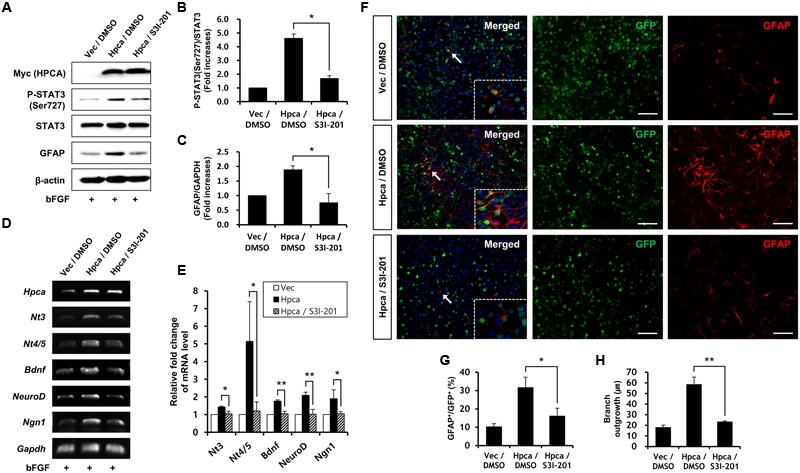
Inhibitory effect of STAT3 (Ser727) activation on astrocytic differentiation of HNPCs. (A) HNPCs were transfected with pMSCV-IRES-EGFP or pMSCV-Hpca-myc-IRES-EGFP for 48 h and then treated with 10 μM S3I-201 for 24 h. Cells were lysed and analyzed by western blotting with anti-Myc, anti-p-STAT3 (Ser727), anti-STAT3, anti-GFAP, and anti-β-actin. (B,C) Graphs show mean densities as fold increases from three independent experiments (means ± SD). Band intensities were quantified with Quantity Ones® software. ∗p < 0.01 compared with the Hpca/DMSO. (D,E) Cells were transfected with pMSCV-IRES-EGFP or pMSCV-Hpca-myc-IRES-EGFP for 48 h and then treated with 10 μM S3I-201 for 24 h. mRNA levels of neurotrophins and proneural bHLH transcription factors were measured by RT-PCR (D) and real-time PCR (E). Graph shows mean densities as fold increases in three independent experiments (means ± SD). ∗p < 0.05; ∗∗p < 0.01 compared with the Hpca/DMSO. (F) Cells were transduced with EGFP vector or Hpca-myc-EGFP for 48 h and then treated with 10 μM S3I-201 for 24 h. Fixed cells were immunostained with anti-GFP (green) and anti-GFAP (red). Bar, 100 μm. The boxed area is magnified and the arrow indicates magnified cells. (G,H) GFAP-positive cells were counted under a fluorescence microscopy and branch lengths were measured in randomly selected areas from five cultures. Data are means ± SD of five values. ∗p < 0.05; ∗∗p < 0.001 compared with the Hpca/DMSO.